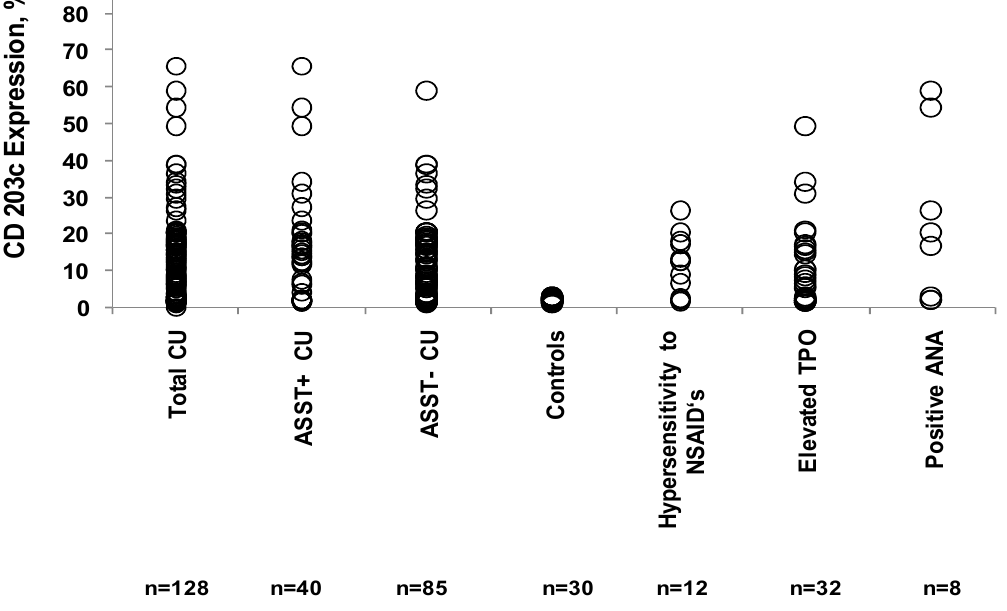
Figure 7. Serum-induced CD203c expression in the whole group of CU patients and in various patient’s subpopulations (ASST+ and ASST- CU patients, CU patients with other autoreactivity markers and controls). No significant differences in CD203c expression between different groups of CU patients were found.